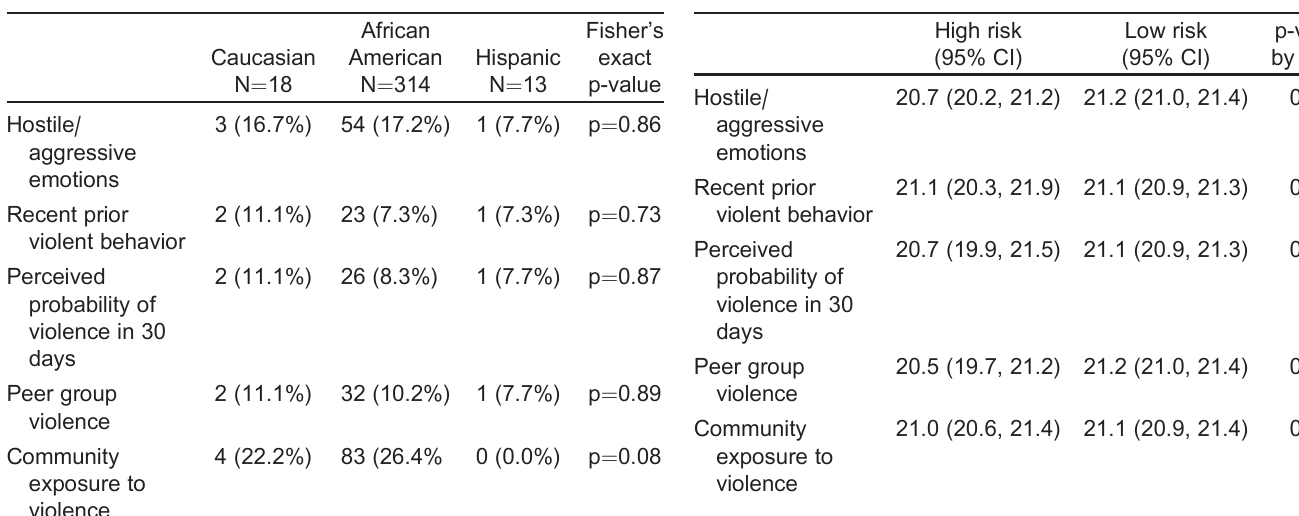
Table 4. Mean age among persons at high versus low risk according to different violence risk factors.